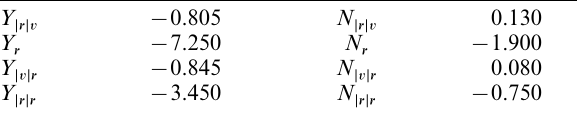
Table 4. Adaptively estimated parameters for CyberShip II